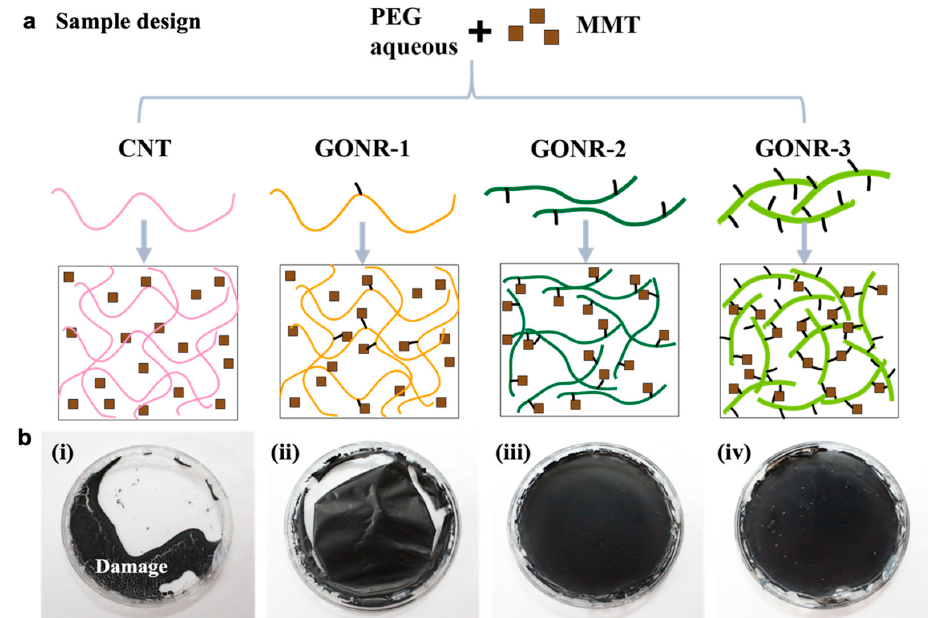
Figure 3. Design and fabrication of PEG/GONR/MMT nanocomposite papers: ( a ) design of the PEG/GONR/MMT nanocomposite papers with different GONR derivatives; ( b ) photos of the PEG/GONR/MMT nanocomposite papers: ( i ) CNT; ( ii ) GONR-1; ( iii ) GONR-2; and ( iv ) GONR-3.